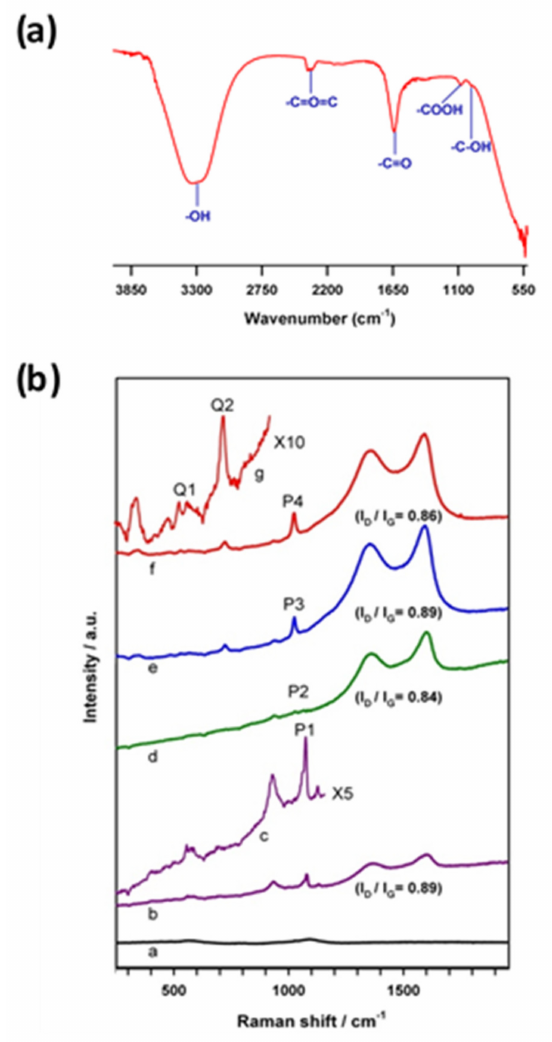
Figure 8. ( a ) FTIR of the electrochemically exfoliated carbon nanoparticles prepared at 0 ◦ C. ( b ) Raman spectra of carbon nanoparticles coated on ITO substrate: a: bare-ITO, and the electrochemically exfoliated carbon nanoparticles prepared at various temperatures; b: 0 ◦ C; c: 0 ◦ C spectrum magnified by a factor of 5; d: 20 ◦ C; e: 30 ◦ C; and f: 40 ◦ C; g: 40 ◦ C spectrum magnified by a factor of 10 in